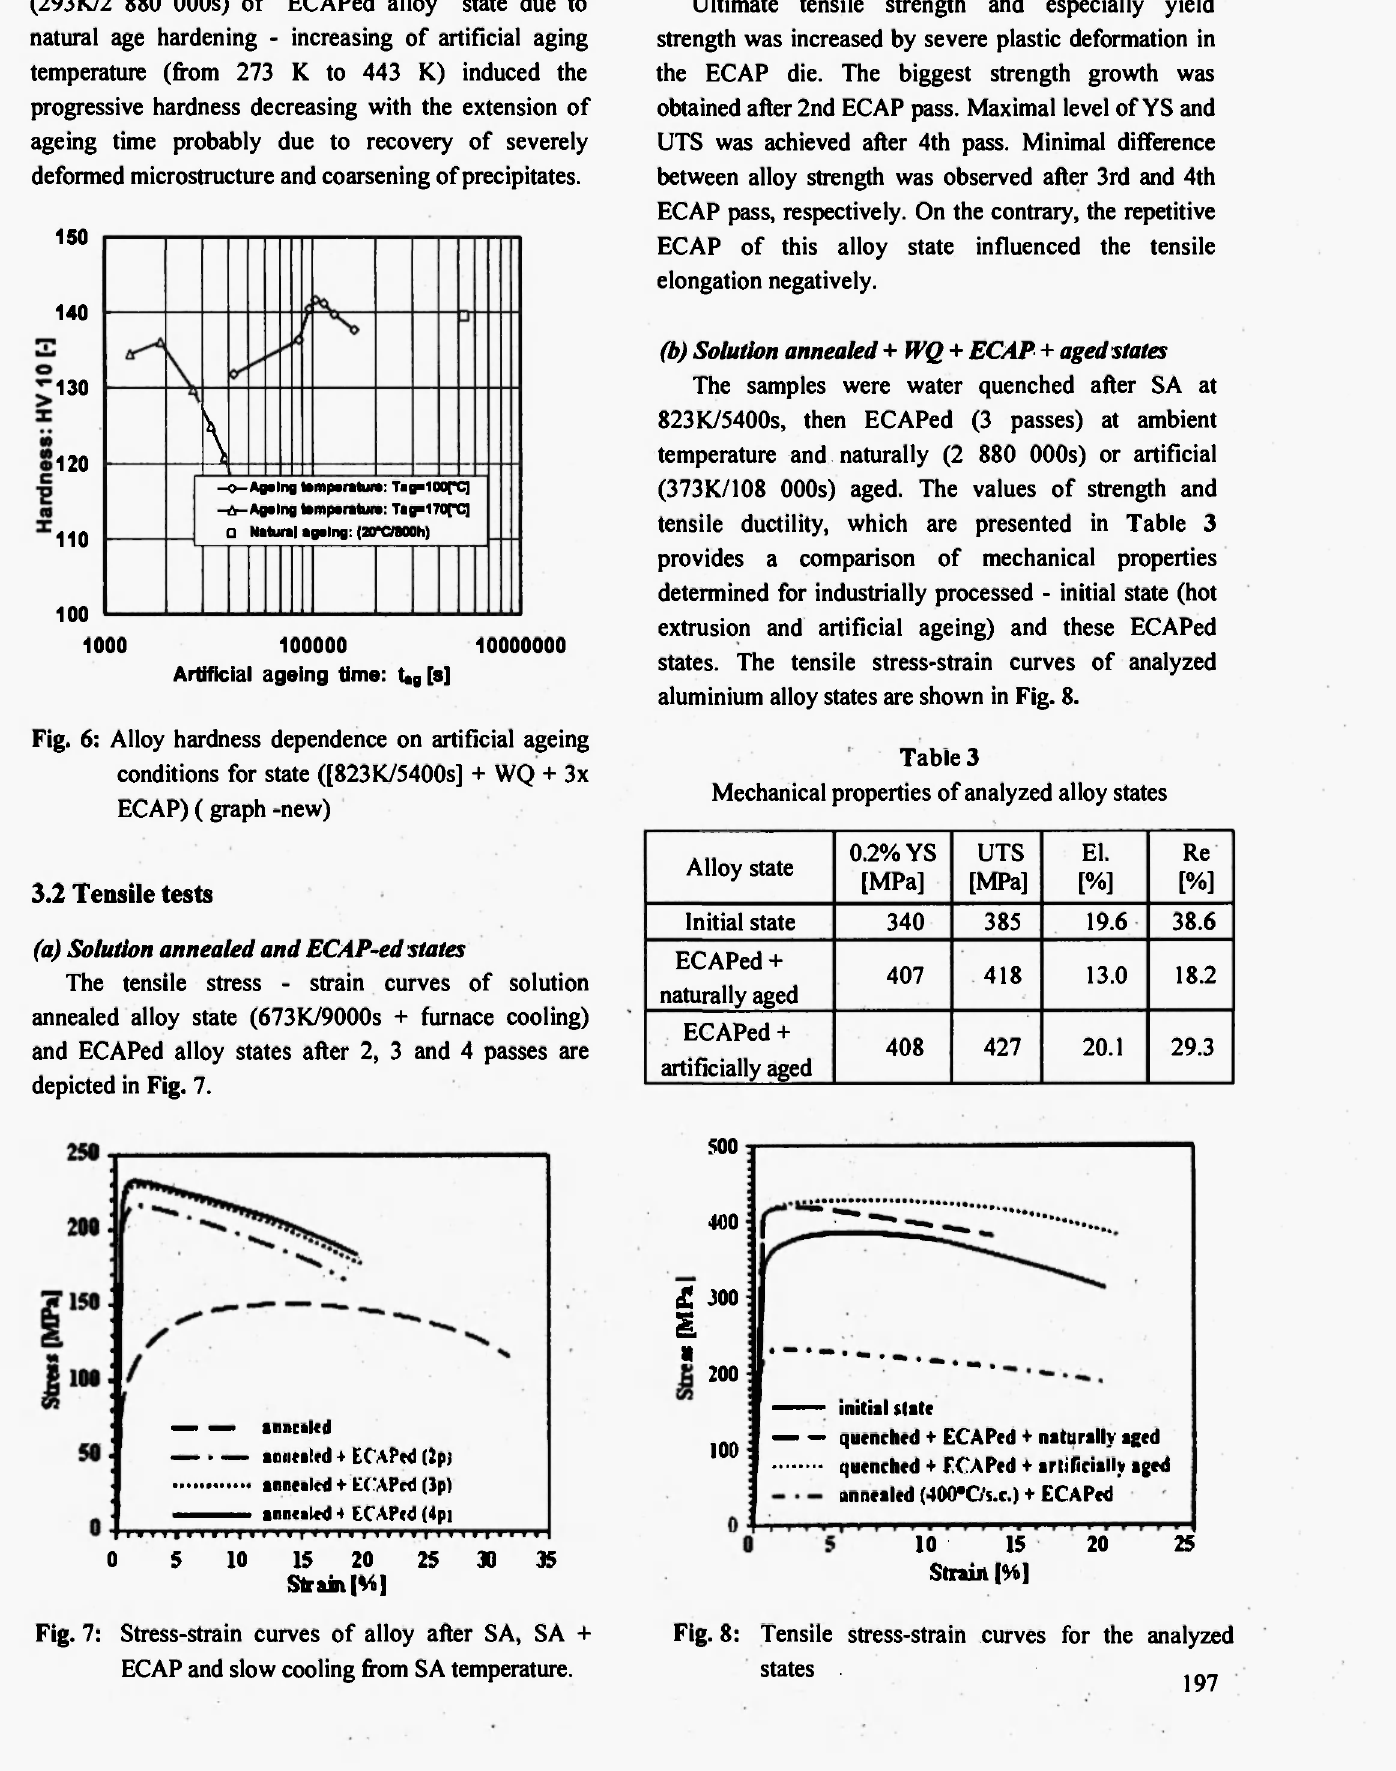
Fig. 7: Stress-strain curves of alloy after SA, SA + ECAP and slow cooling from SA temperature.